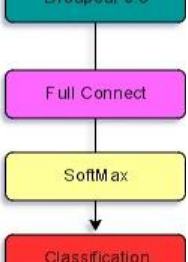
Figure 5. Inception V4 architecture.